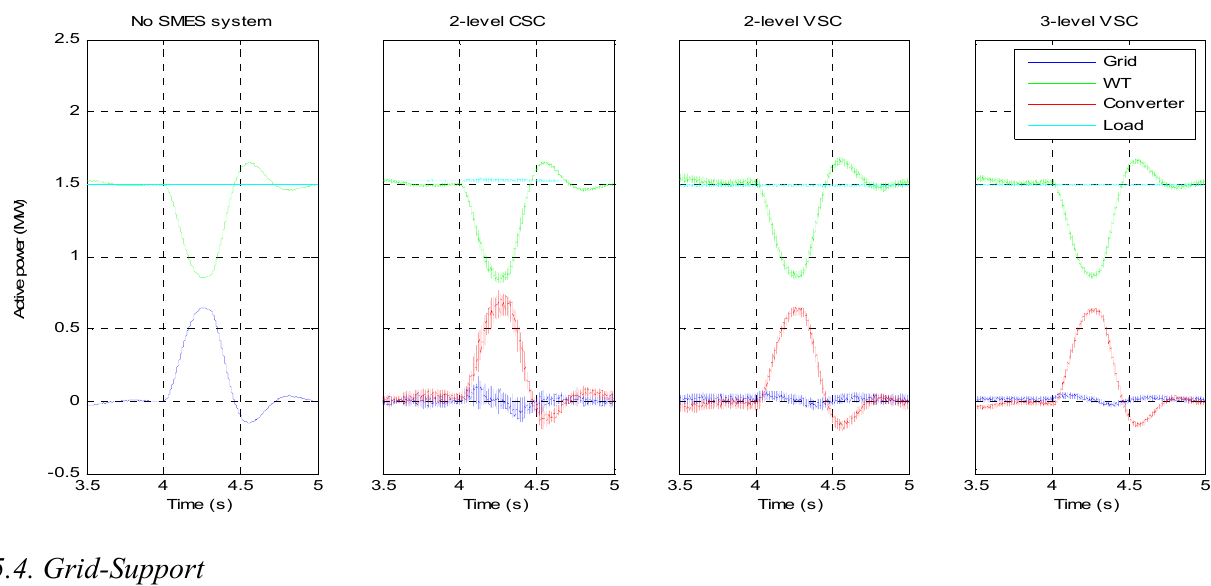
Figure 24. Operation with and without SMES system for load-sharing application.